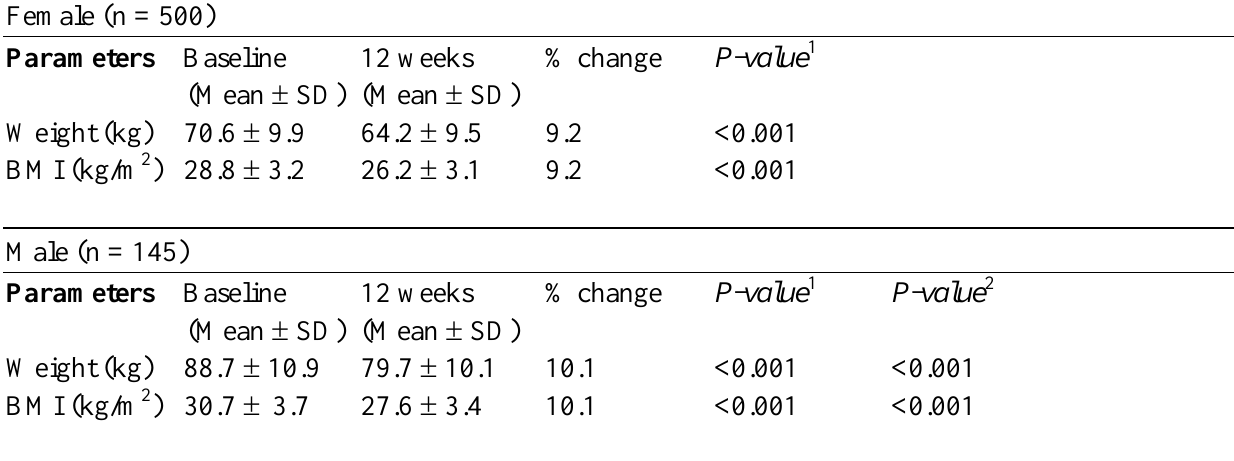
Table 2. Comparison of changes in weight and clinical outcomes before and after the